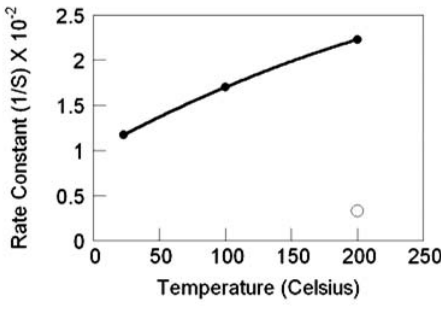
Figure 24. TiO nanowire sensor response rate versus temperature, filled circles are with 2 Pt catalyst, the nonfilled circle is without catalyst.